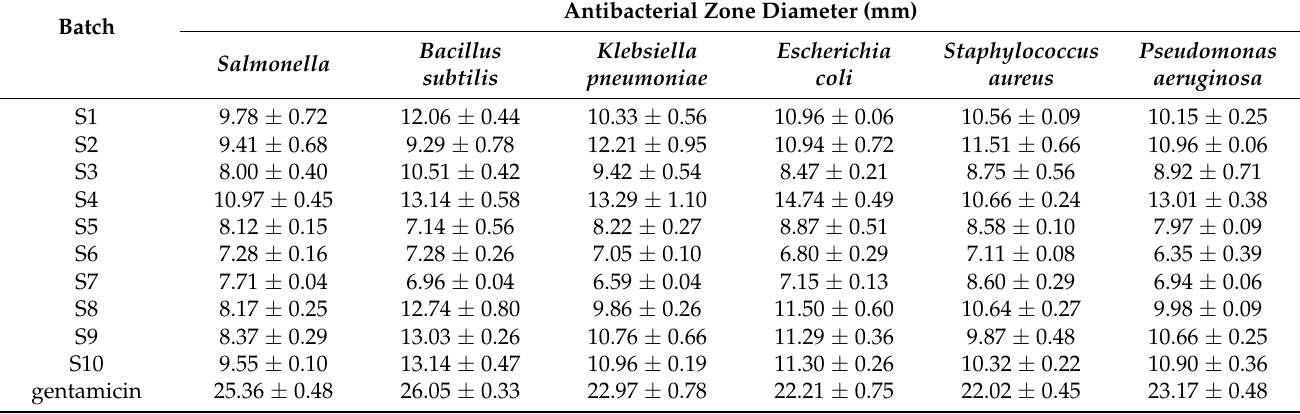
Table 2. Antibacterial zone diameter results.